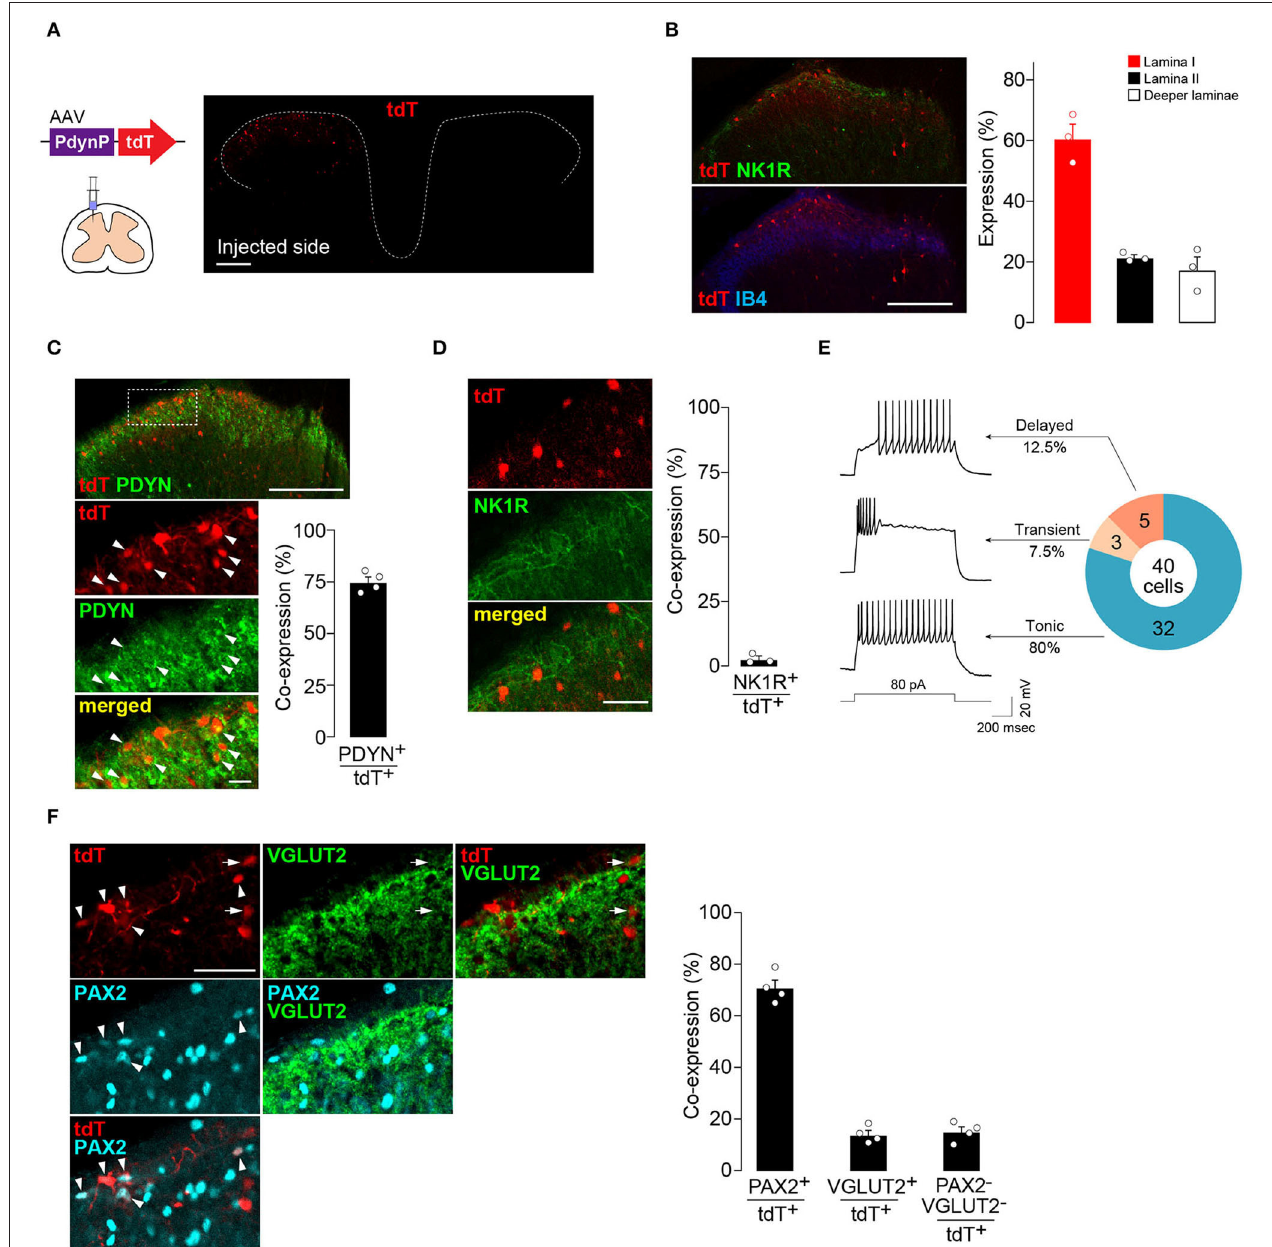
FIGURE 1 | AAV-PdynP injected into rat spinal dorsal horn (SDH) captures a subset of inhibitory neurons. (A) tdTomato (tdT) expression in the fourth lumbar (L4) SDH at 4 weeks after microinjection of AAV-PdynP-tdT. Schematic illustration indicates intra-SDH microinjection of the AAV vector. Scale bar, 200 µ m. (B) Immunolabeling of tdT + cells (red) with lamina-selective markers (green, NK1R; blue, IB4) in the L4 SDH. Scale bar, 200 µ m. Quantification of the distribution of tdT + cells ( n = 3 rats tested, 272 total tdT + cells quantified). (C) Immunofluorescence of prodynorphin (PDYN; green) in tdT + SDH neurons (red). Scale bar, 200 µ m (above), 20 µ m (below). Arrowheads indicate tdT + PDYN + neurons. The percentage of tdT + PDYN + neurons per total tdT + neurons was quantified ( n = 4 rats tested, 1,281 total tdT + cells quantified). (D) No colocalization of tdT (red) with NK1R (green). Scale bar, 50 µ m. The percentage of co-expressing neurons was quantified ( n = 3 rats tested, 187 total tdT + cells quantified). (E) Firing patterns of tdT + SDH neurons, and the percentage of neurons displaying each pattern. APs were evoked by current injection (80pA). (F) Colocalization of tdT (red) with PAX2 (blue) and VGLUT2 (green) in the superficial laminae. Arrowheads and arrows indicate tdT + PAX2 + and tdT + VGLUT2 + neurons, respectively. Scale bar, 50 µ m. The percentage of co-expressing neurons was quantified ( n = 4 rats tested, 456 total tdT + cells quantified). Data shown as mean ± SEM.